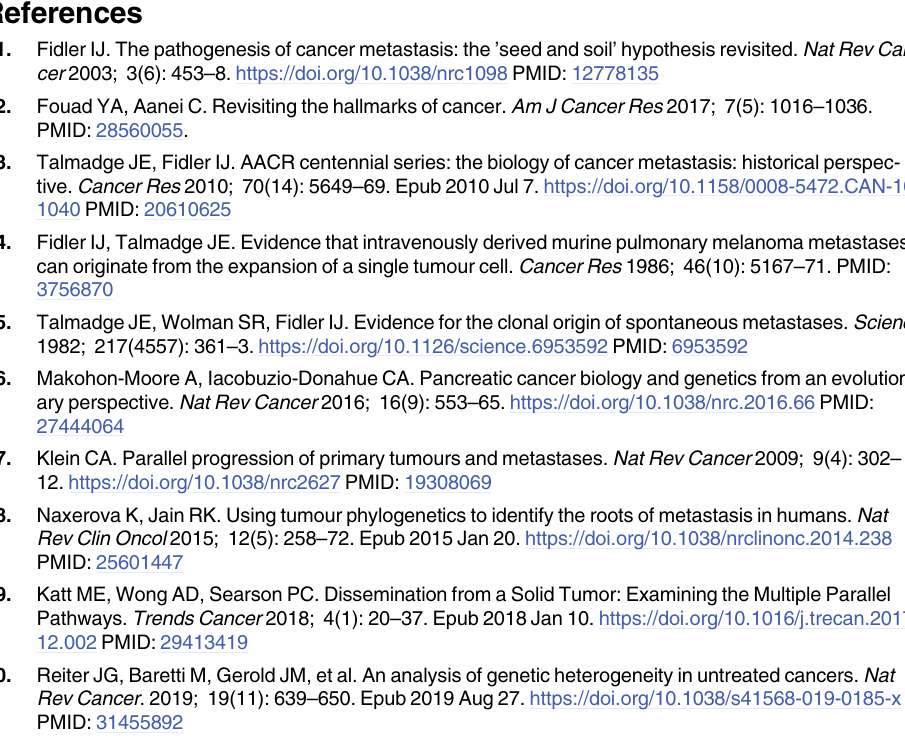
S2 Table. Outcome of patients with lung